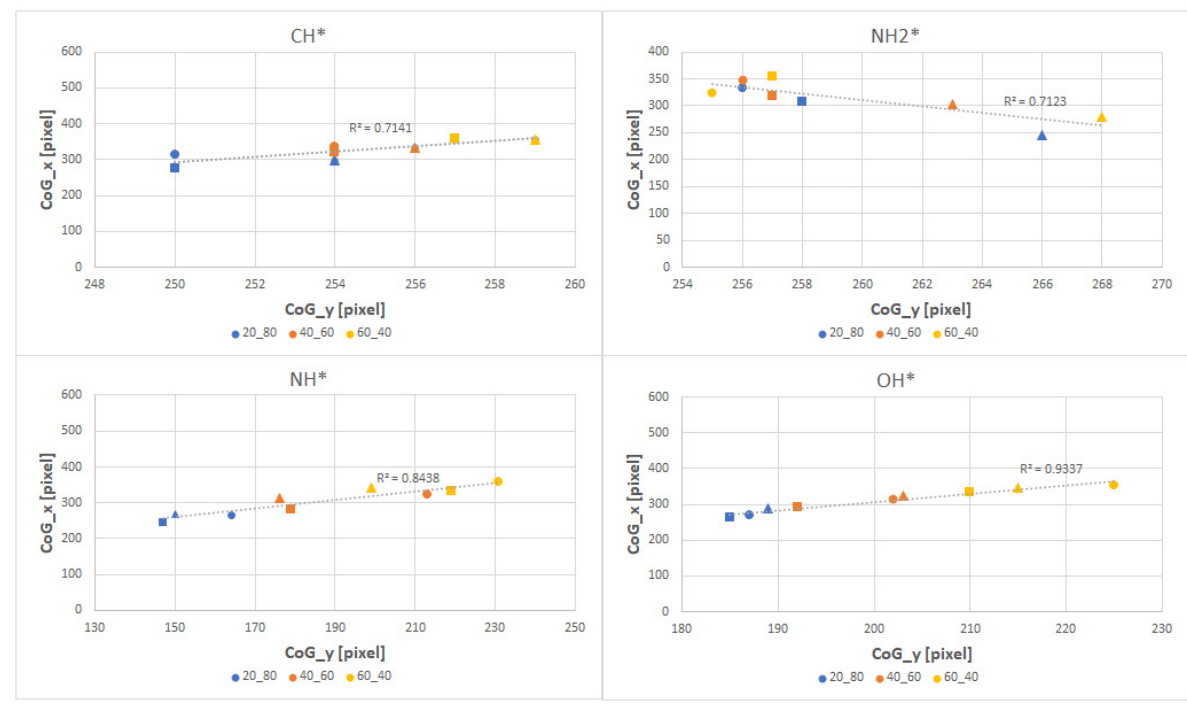
Figure 6. Centre of gravity of chemiluminescence results of various blends (20/80, 40/60, 60/40 vol% methane/ammonia). Figures ( ● ) stoichiometric, ( ▲ ) lean and ( ) rich conditions.